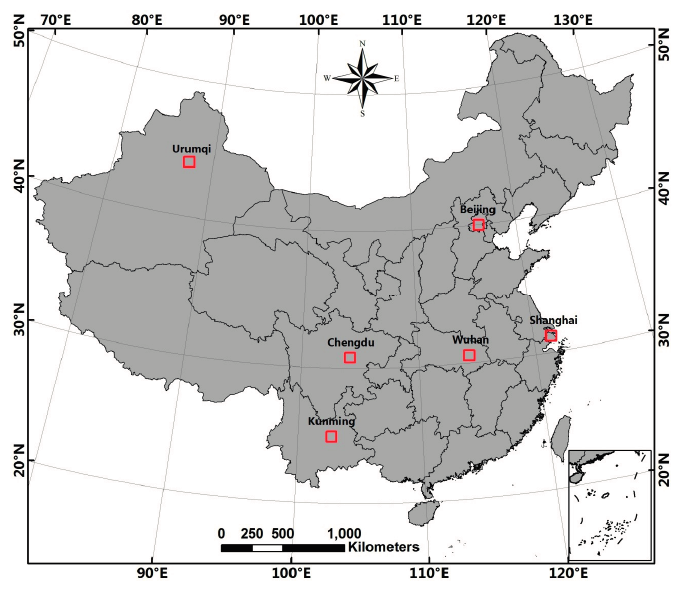
Figure 1. The study area—all of China and six selected